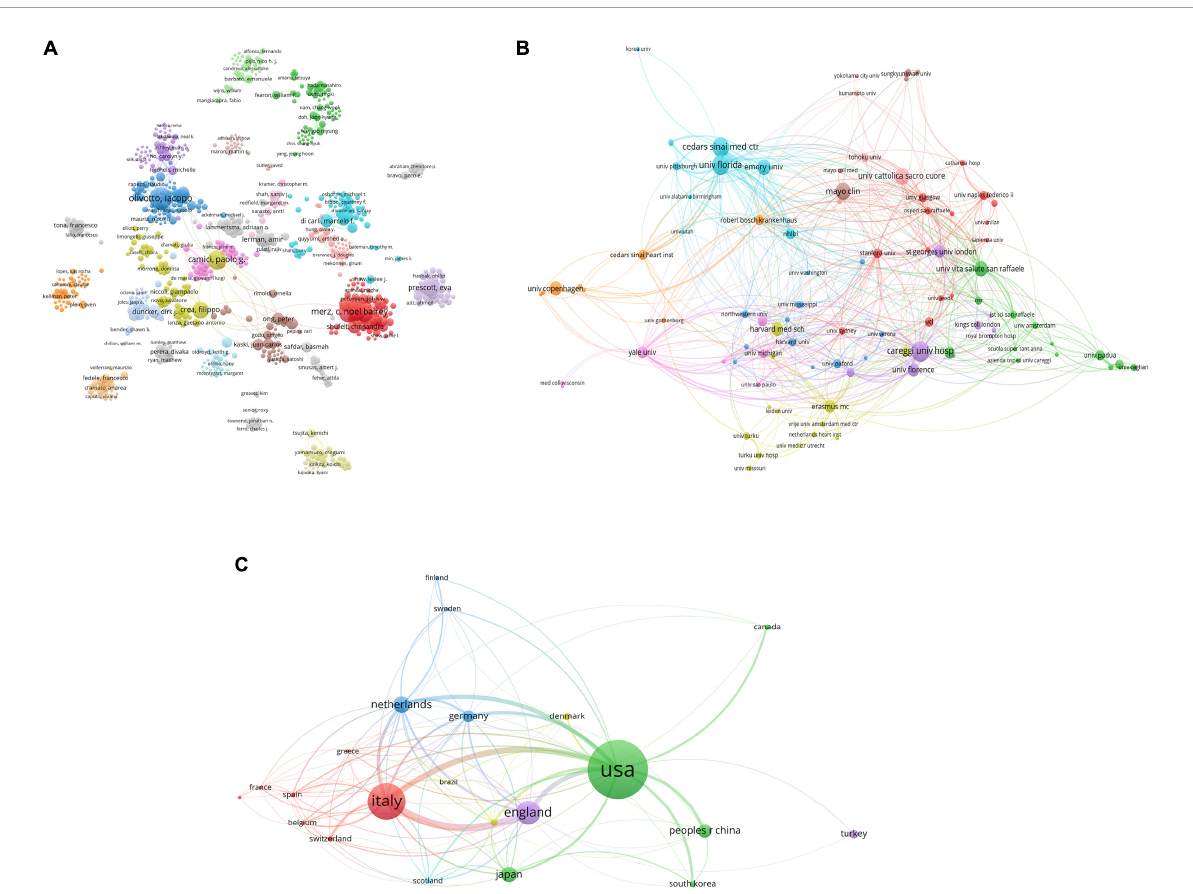
FIGURE3 Visualization knowledge maps of the co-authorship. (A) The co-authorship map of authors which indicates the authors that cooperate in the field of CMD; (B) the co-authorship map of organizations. The institution with the strongest total link strength is the University of Florida. (C) The co-authorship map of countries. The number of collaborators with the USA is 300 and the total link strength is 230. Different colors indicate different clusters and the size of nodes indicates the number of publications. The thickness of the lines represents the link strength of the